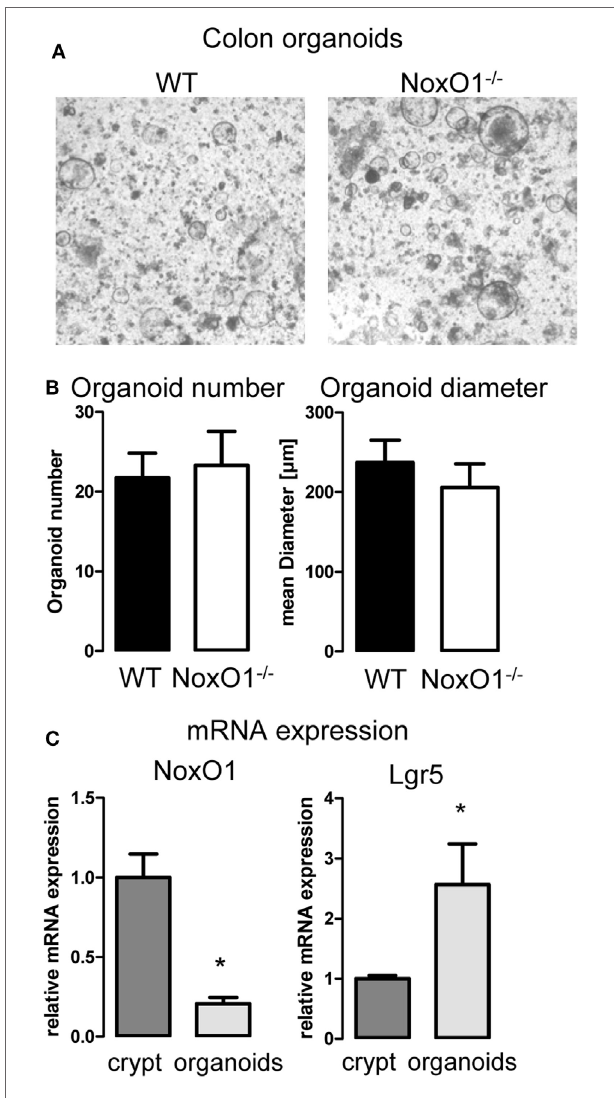
FigUre 3 | Colon organoid growth. (a) 3D culture of organoids generated from colon crypts isolated from wild-type (WT) and NoxO1 knockout (NoxO1 − / − ) animals. Representative pictures of organoids after 7 days in culture. (B) Analysis of organoid number and mean diameter of organoids cultured for 7 days. Organoids were counted per field of vision. Per animal two wells were analyzed. n = 5. (c) mRNA expression relative to housekeeping gene EF of NoxO1 and stem cell marker Lgr5 in freshly isolated crypts and organoids cultured for 7 days. n = 3, * p <